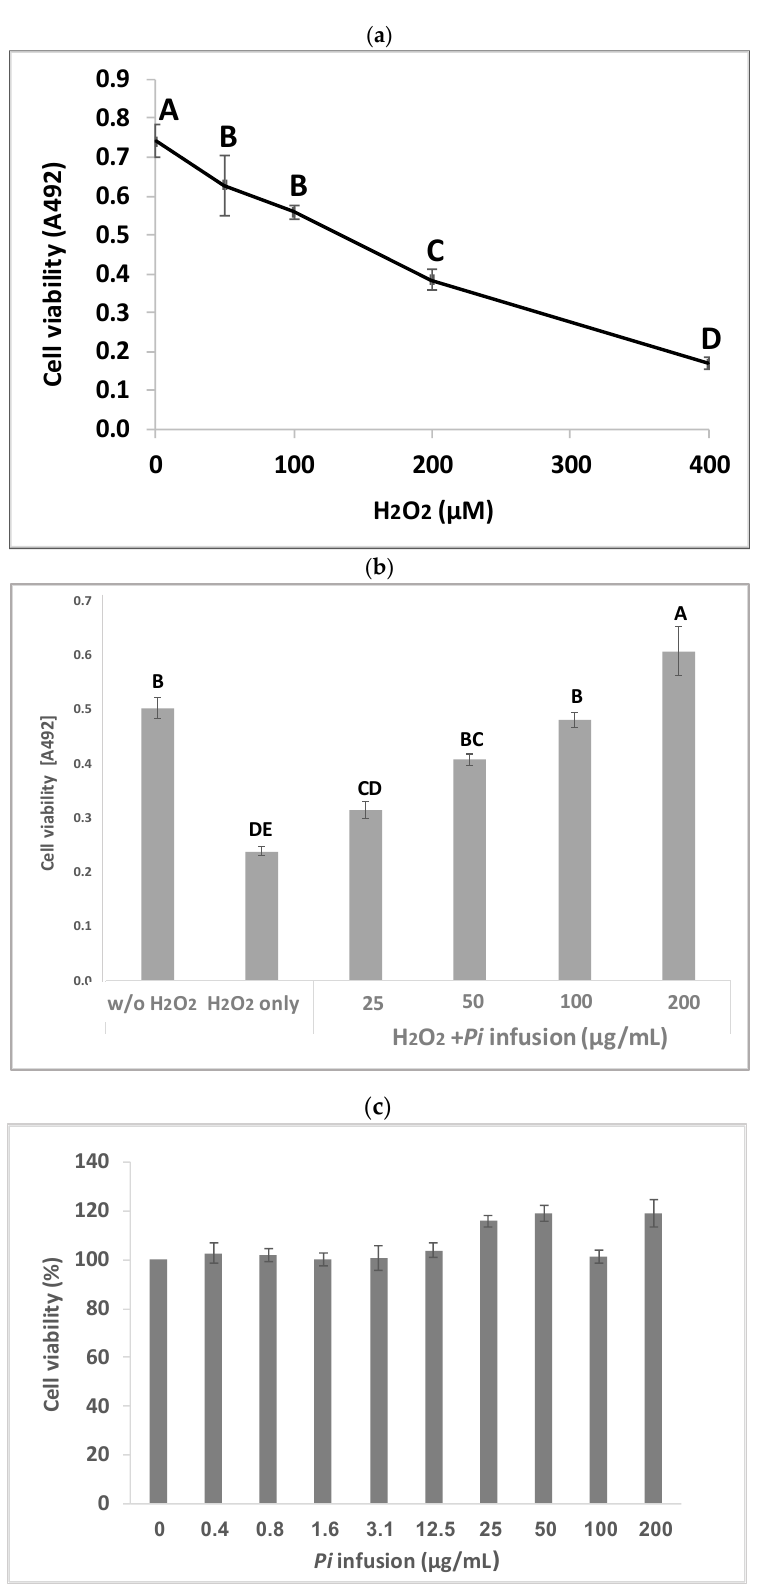
from cell death (Figure 2b). Of note, no Pi infusion cytotoxicity was recorded at any con- centration tested (Figure 2c).